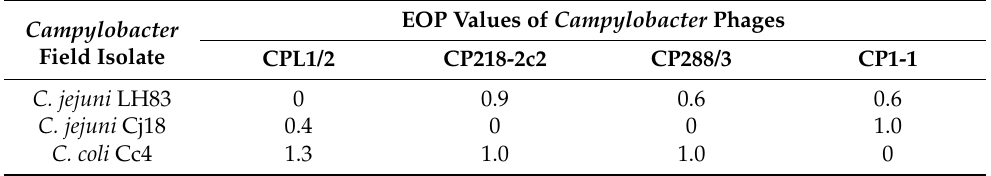
Table 2. EOP values for the phage–bacteria combinations used during PKA